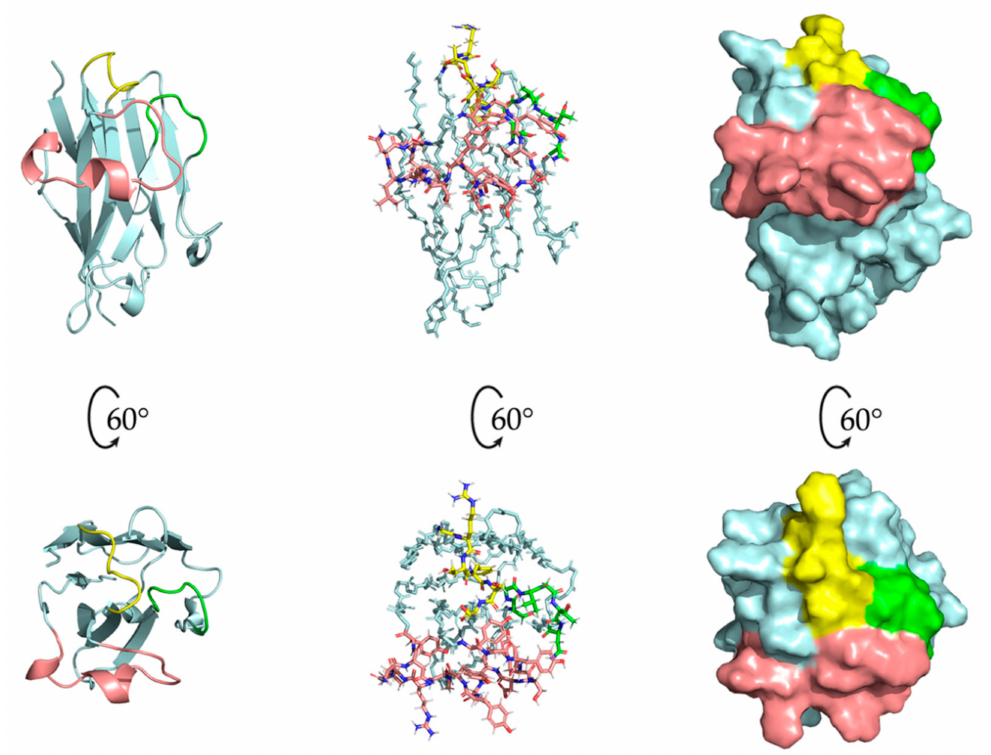
Figure 6. The CDRs of Nb23, with CDR1 in yellow, CDR2 in green, and CDR3 in salmon. The left column shows the cartoon representation of Nb23 without any sidechains. The central column shows the CDRs with sidechains (and only backbone for the β − core). The right column shows the surface of the protein with the CDRs highlighted. The predominance of the CDR3 in the antigen − binding site is evident, highlighting its importance in interacting with the antigen(s). Its orientation affects the size and shape of the antigen-binding site for the unbound nanobody, although the flexibility in residues 102 − 106 suggests that the CDR3 conformation may change as the nanobody binds its